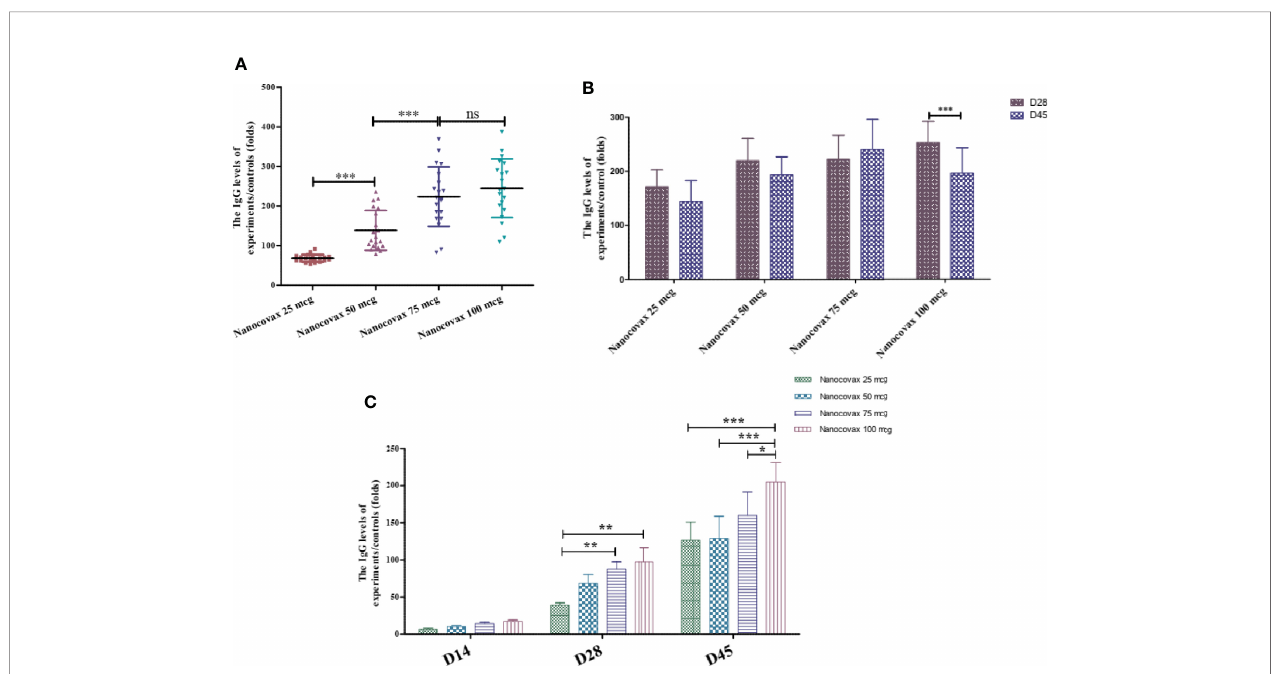
FIGURE 3 | Immunogenicity of Nanocovax vaccine using different animal models. The BALB/c mice were intramuscularly injected twice 7 days apart. Blood was collected on day 14 to determine SARS-CoV-2 S protein-speci fi c antibody IgG levels by ELISA (A) . Syrian hamsters were intramuscularly injected twice 7 days apart. Blood was collected on day 28 and day 45 to determine SARS-CoV-2 S protein-speci fi c antibody IgG levels by ELISA assay (B) . Northern pig-tailed macaques were intramuscularly injected twice 7 days apart. Blood was collected on days 14, 28, and 45 to determine SARS-CoV-2 S protein-speci fi c antibody IgG levels by ELISA assay (C) . The data represent the mean ± SD, and p -values were determined by one-way ANOVA with the Newman – Keuls multiple comparison test and two-way ANOVA analysis with Bonferroni post-hoc tests (*p < 0.05; ** p < 0.01; *** p < 0.001; ns, not signi fi